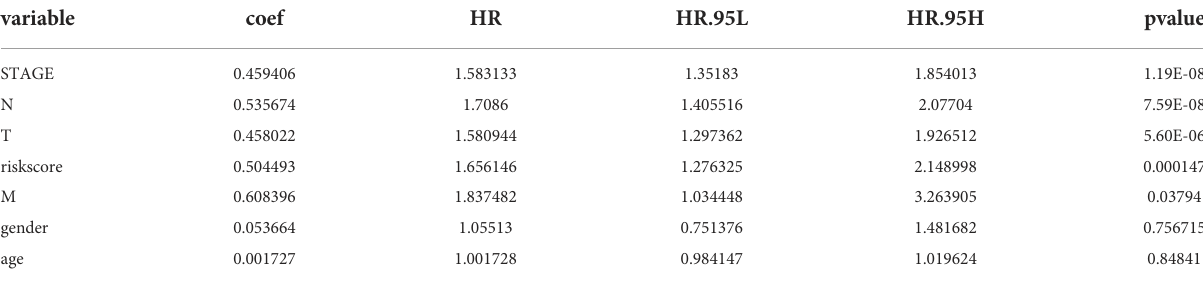
TABLE 8 Prognostic factors associated with LUAD were detected by univariate Cox regression analysis in the GSE50018 dataset. variable